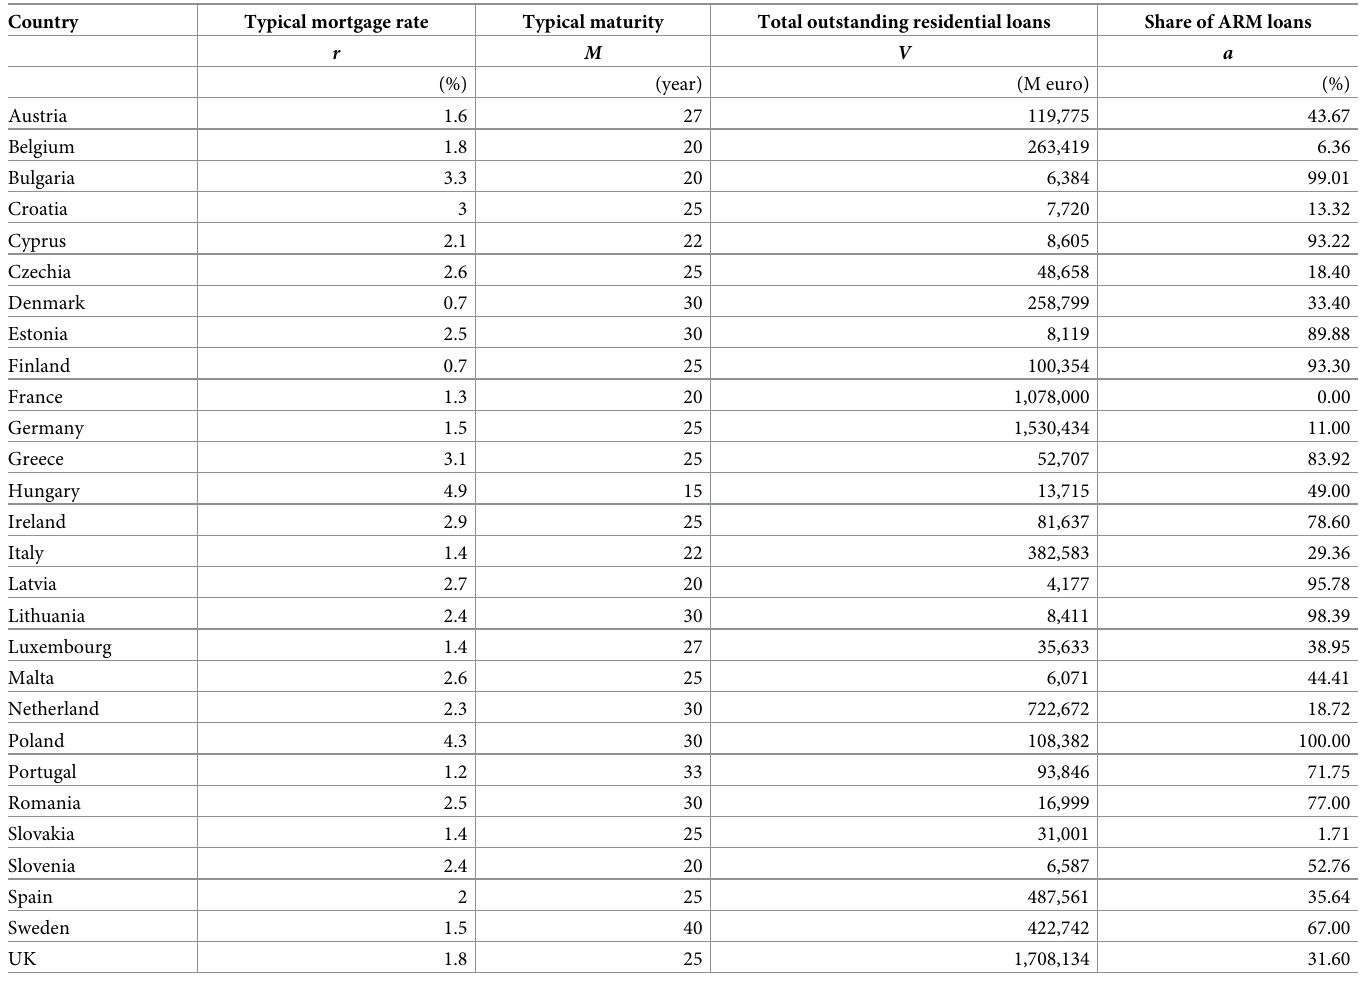
Table 1. Characteristics of mortgage markets in EU countries UK included), November